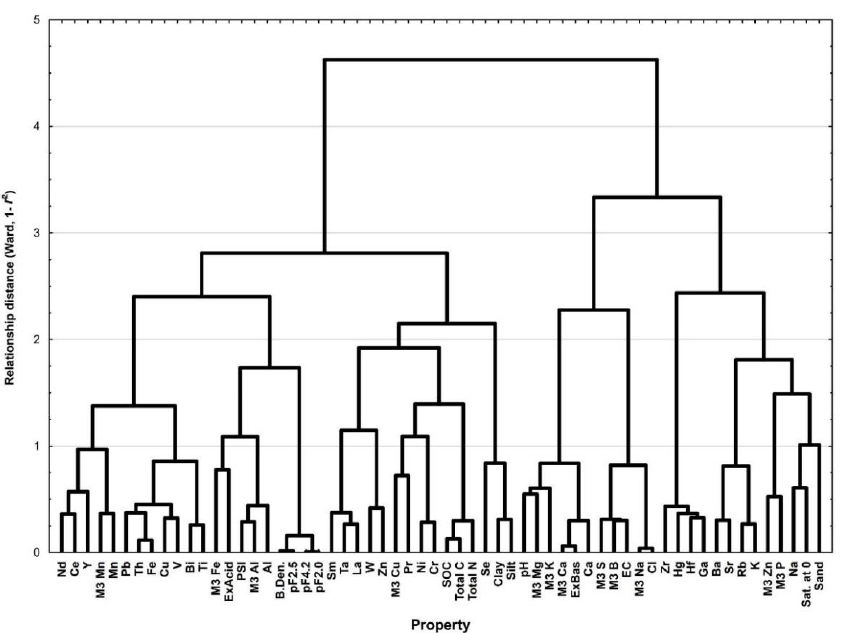
Figure 5. Dendrogram of associations between variables obtained by Ward’s agglomeration method.